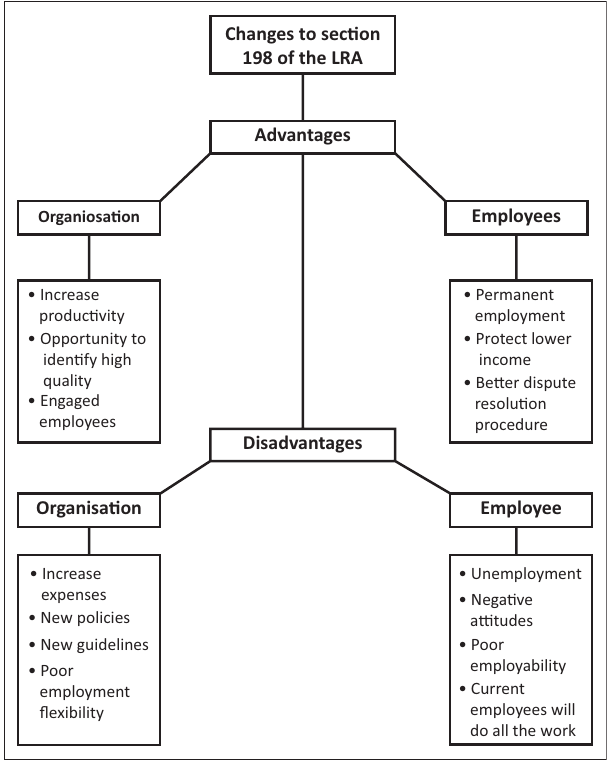
FIGURE 1: Summary of the impact of changes to section 198 of the LRA on an organisation and the